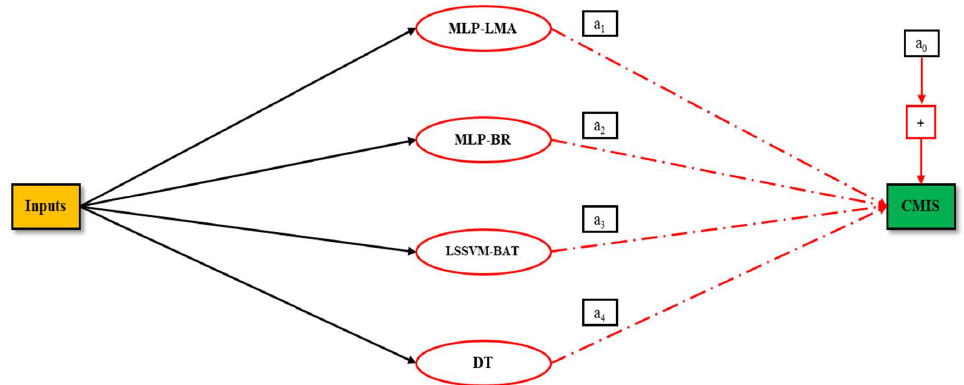
Figure 3. Committee Machine Intelligent System (CMIS) model offered in this